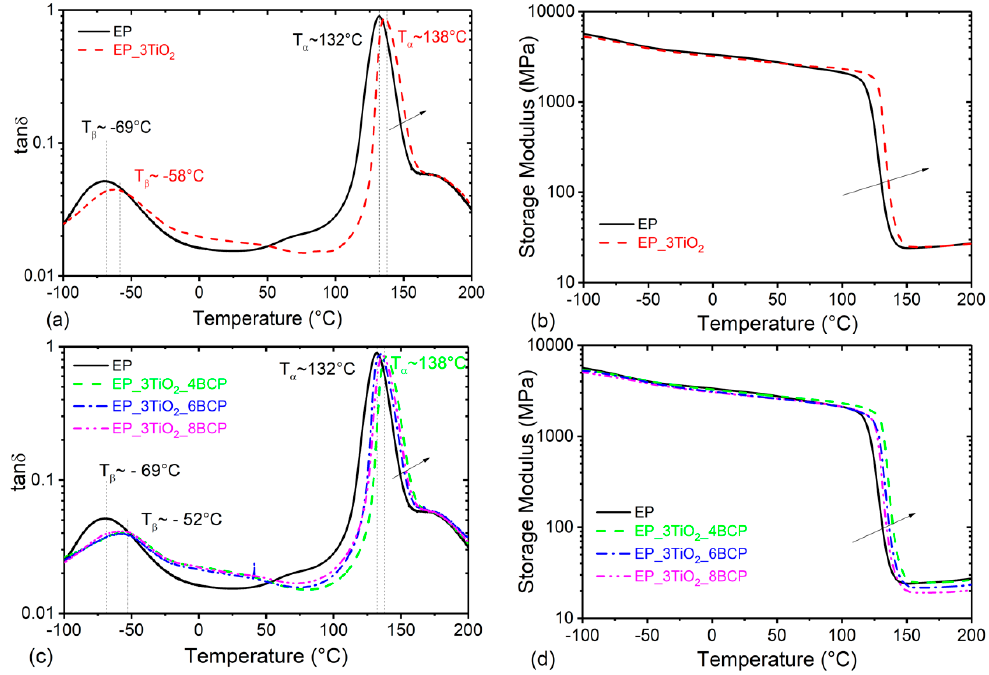
Figure 4 . Graph showing ( a ) tan δ and ( b ) storage modulus, with respect to temperature for the EP_ TiO 2 systems. ( c ) tan δ and ( d ) storage modulus, with respect to temperature for the EP_ TiO 2 _BCP systems.